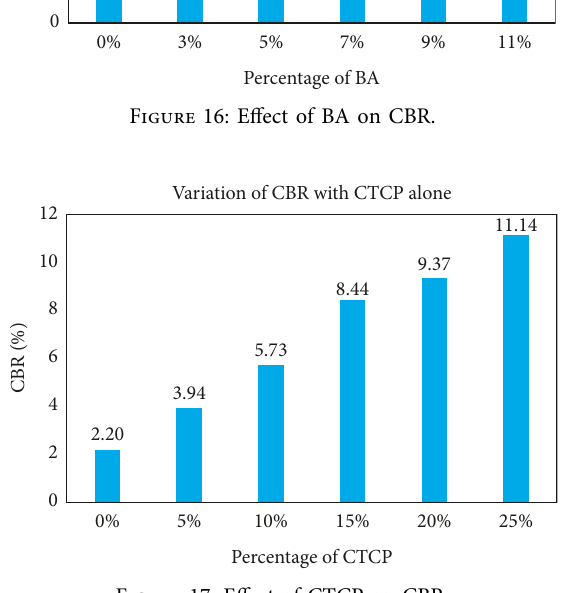
Figure 17: Effect of CTCP on